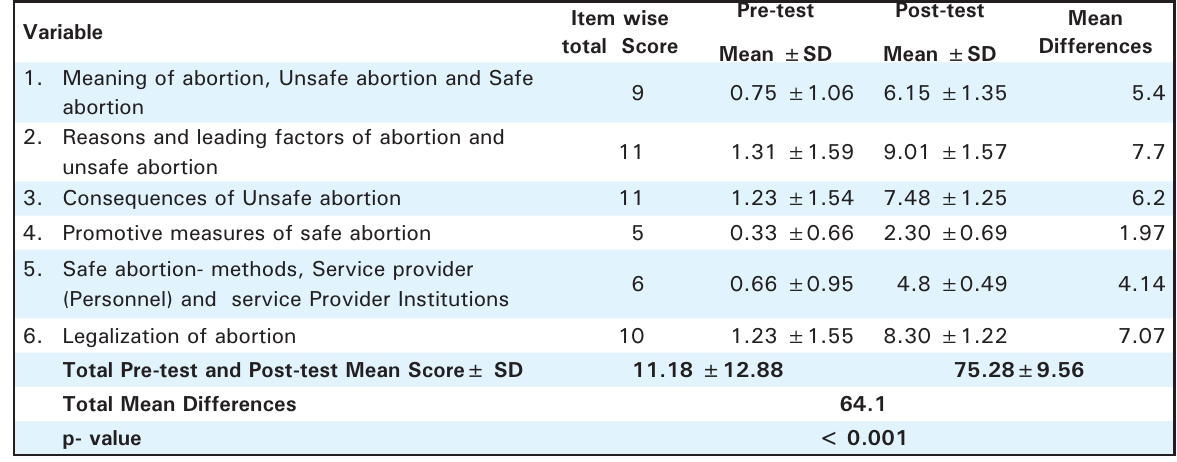
Table 5. Comparison Between Pre-Test And Post- Test Awareness Regarding Abortion, Unsafe Abortion And Safe Abortion